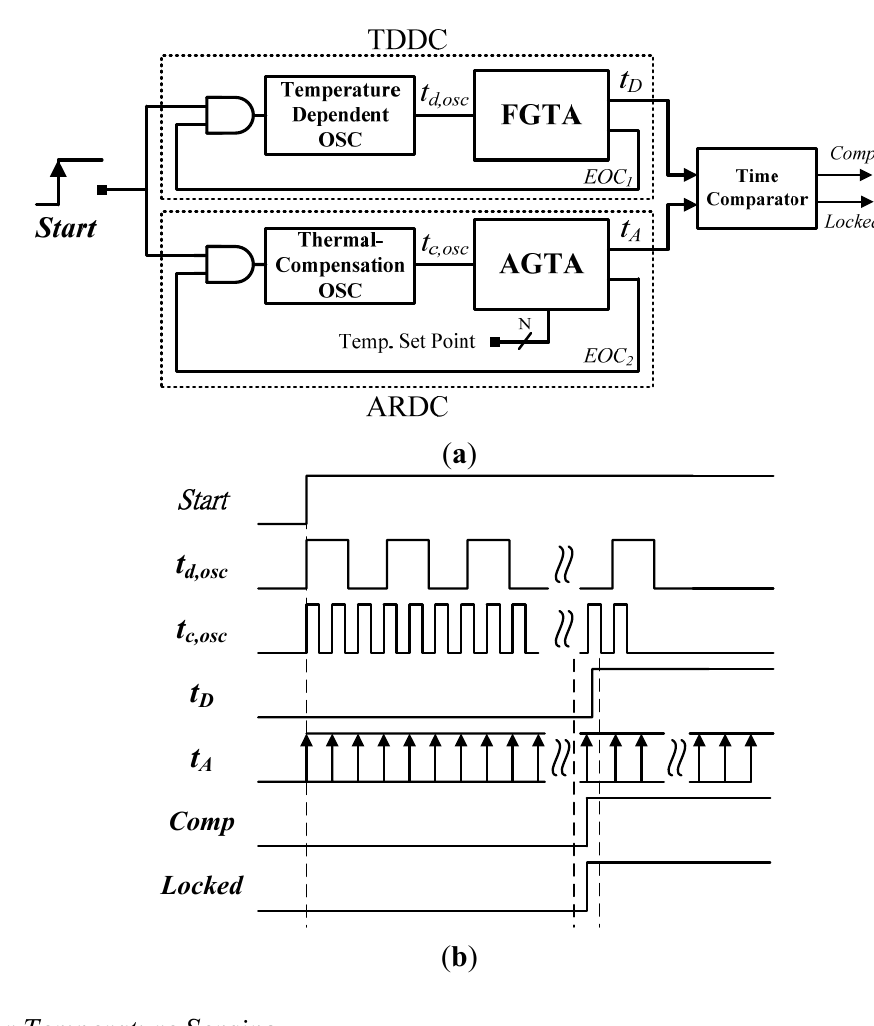
Figure 3. ( a ) Basic structure of the proposed thermostat. ( b ) Operation principle of the proposed